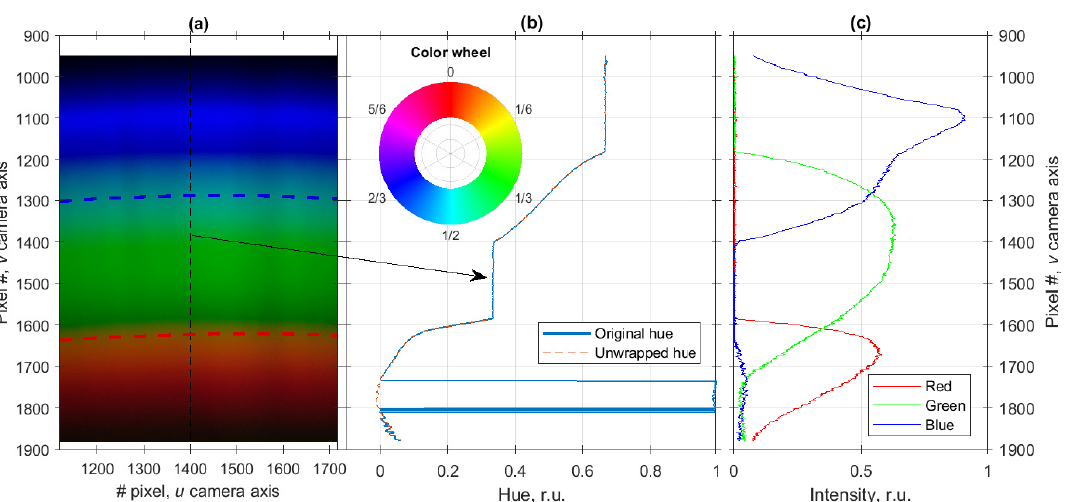
Figure 2. Raw image of the smartphone LED spectrum measured with the smartphone-based spectrometer, the centers of the transition areas are shown with red and blue dashed curves ( a ); corresponding hue distribution along the v axis ( b ); red, green and blue channels’ intensities ( c ). The color wheel in the inset of ( b ) is shown to demonstrate the transformation between the RGB format and hue, as well as the analogy between the hue and the phase (or